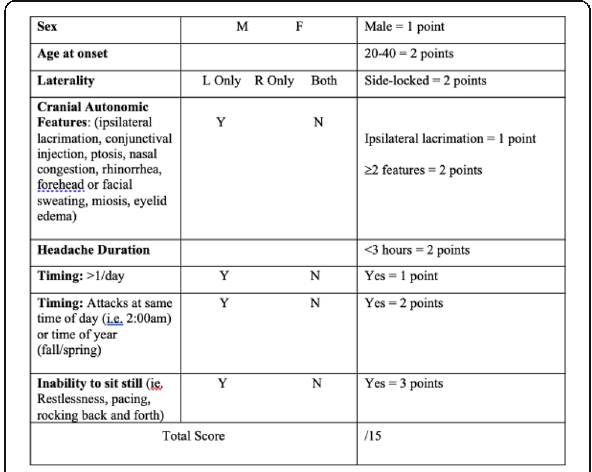
Fig. 1 (abstract P19). Cluster headache screening tool